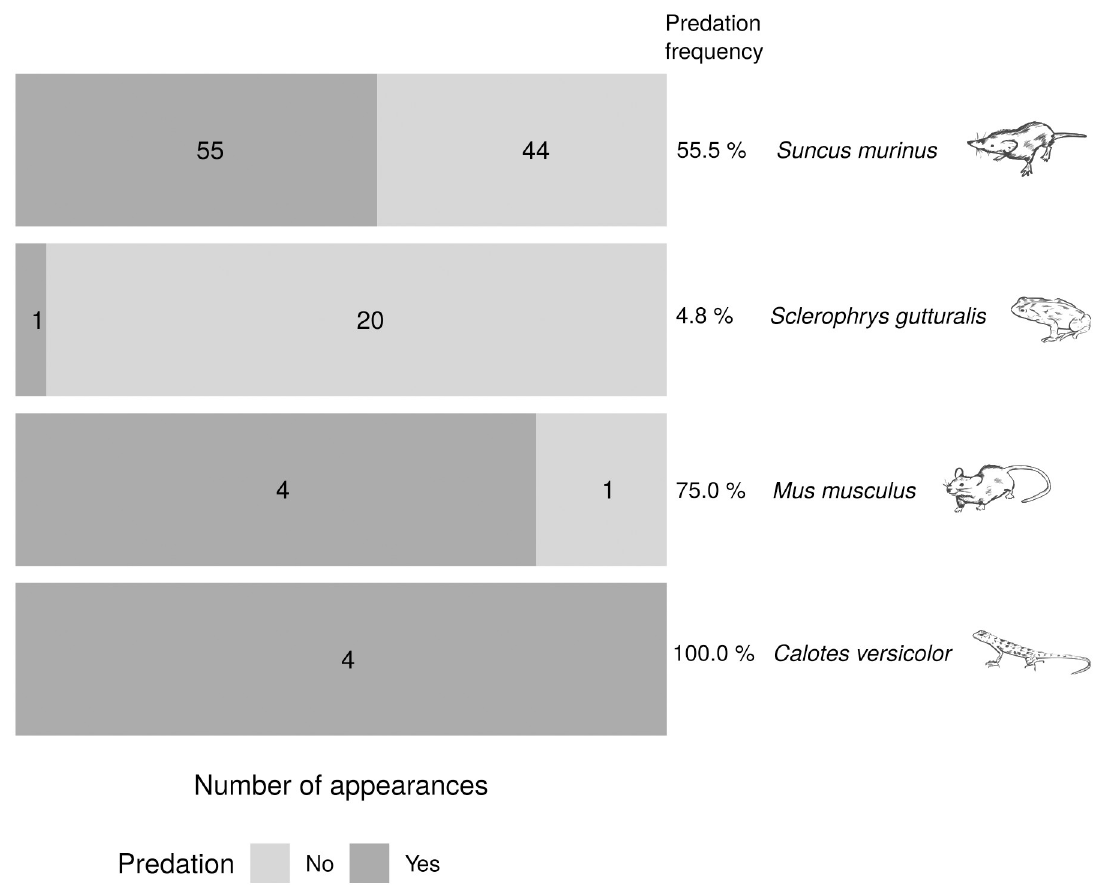
Fig 6. Number of appearances of the different predators with or without predation and the associated predation